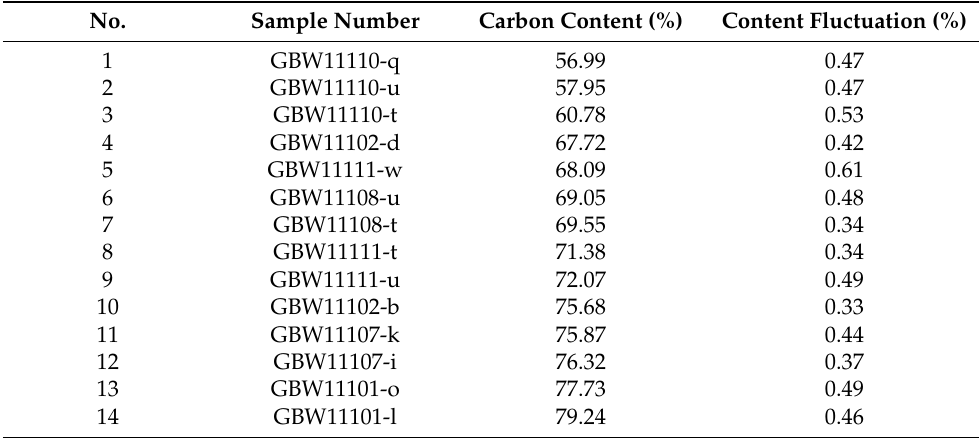
Table 1. Elemental content of coal